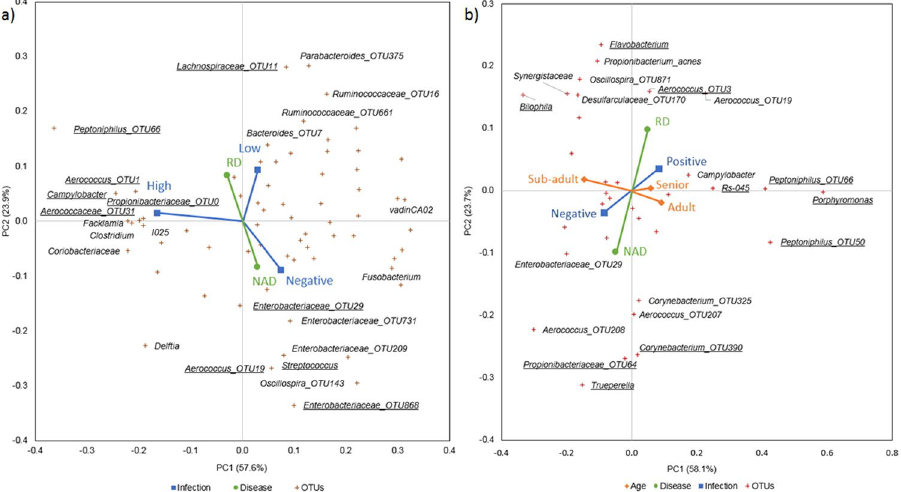
Figure 5. Analysis of variables associated with differences in the koala microbiota core OTUs. Canonical correspondence analysis (CCA) of ( a ) UGT (M6), and ( b ) penile (M14). Names of OTUs that contribute to ≥ 2.5% of variance for first two principal components (PC), PC1 or PC2 of the CCA analysis are presented with the top five contributing OTUs of each PC